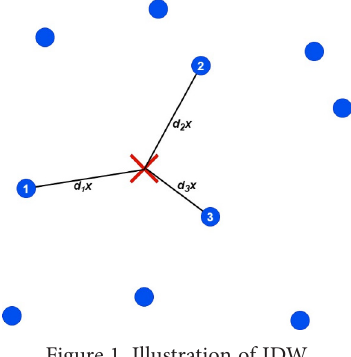
Figure 1. Illustration of IDW